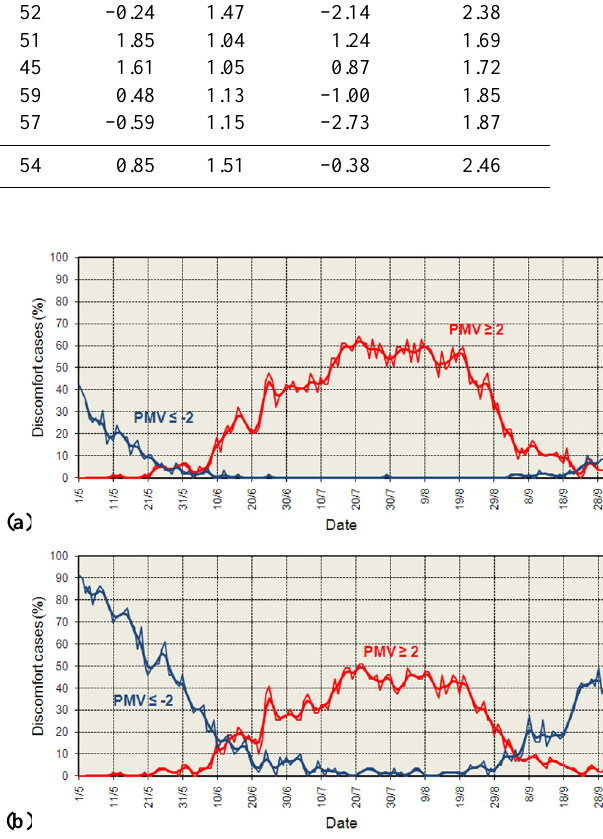
Fig. 6. Mean intra-seasonal (1 May–30 September) variation of dis- comfort frequency at 14:00 in Athens for (a) calm and (b) light wind conditions, for the period 1954–2012 (smoothing as in Fig.